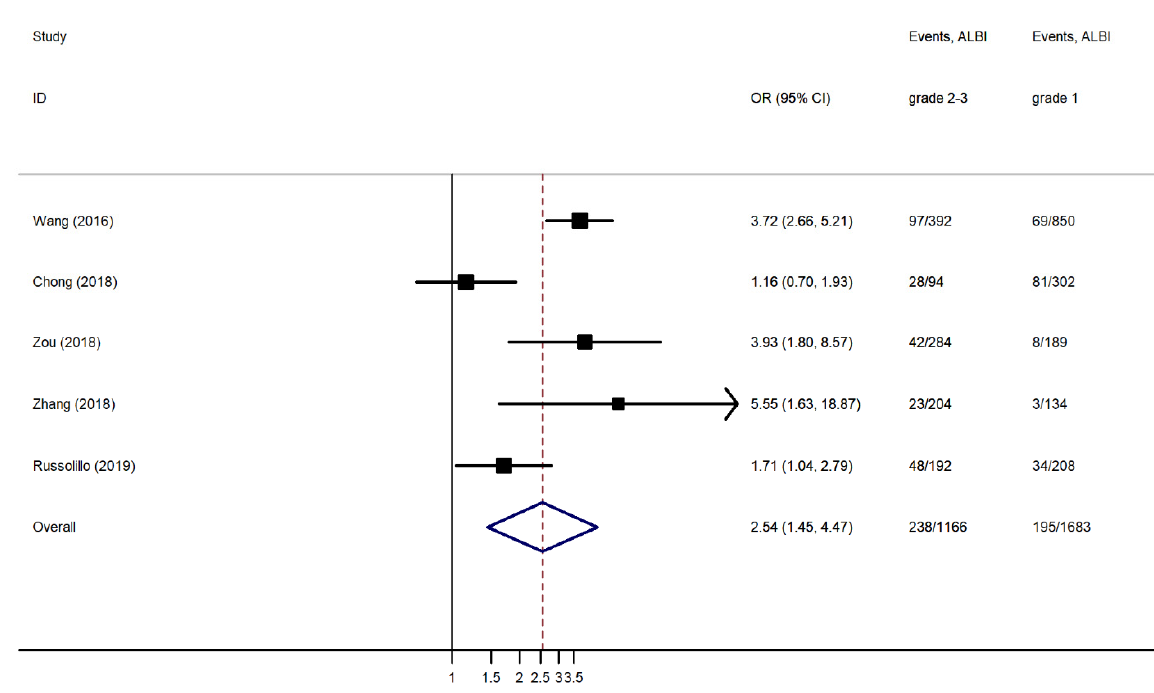
Table 3. Results of the univariable meta-regression analysis.